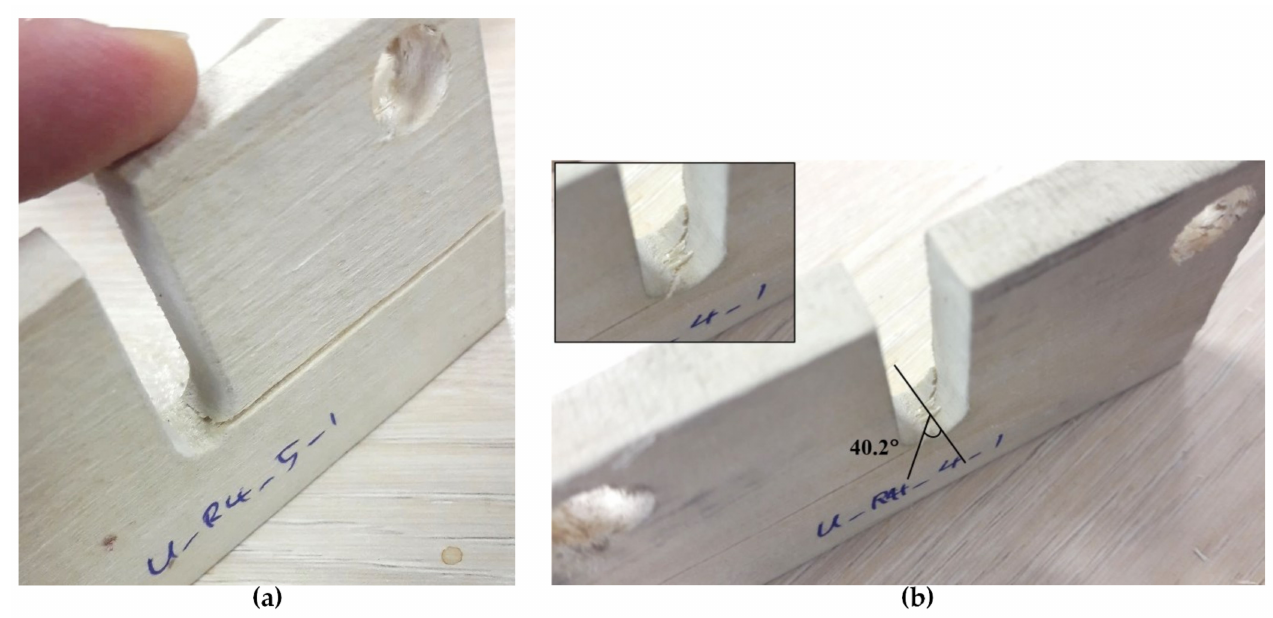
Figure 12. U-notched spruce wood specimens with 4 mm tip radius after failure under the loading angle of: ( a ) β = 0 ◦ (pure mode I); ( b ) β = 72 ◦ .